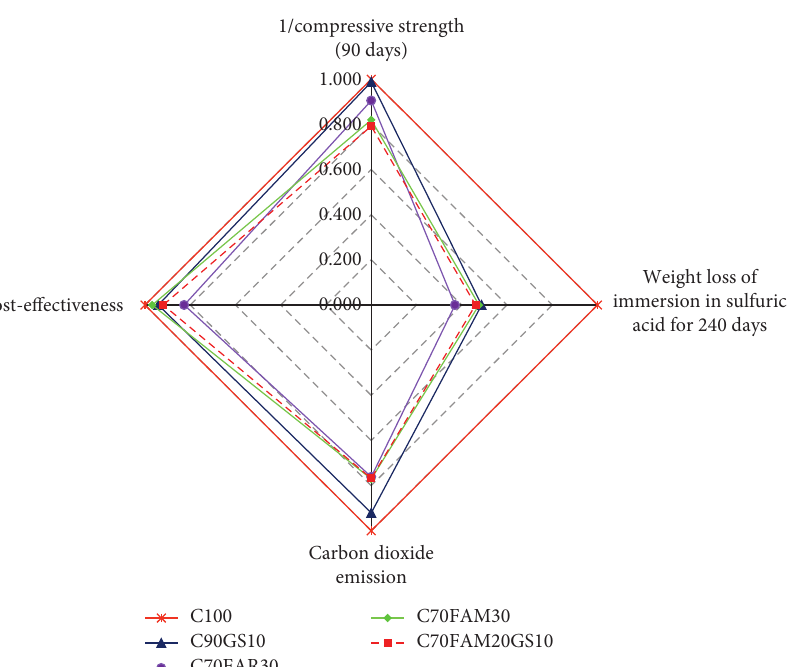
Figure 7: Relative performances of all mixtures, compared to the cement-only (C100) mixture.